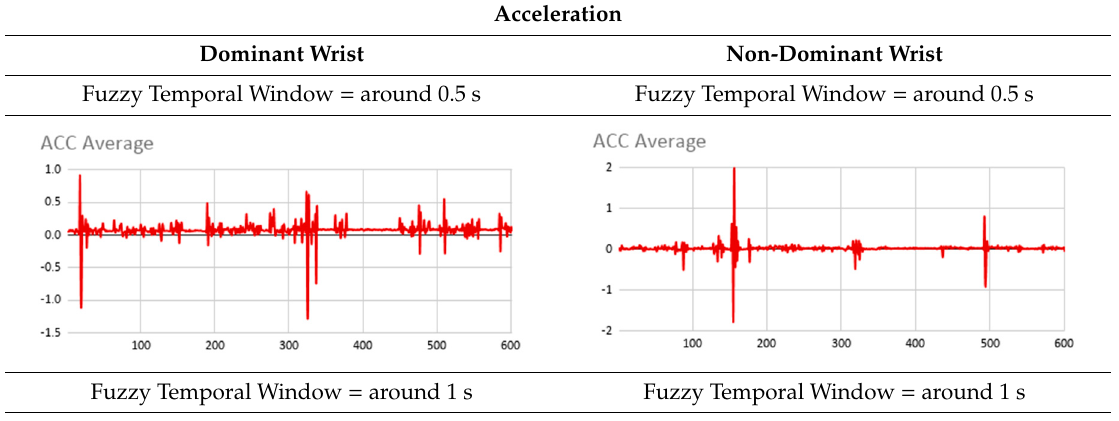
Table 4. Acceleration results with di ff erent fuzzy temporal windows from both wrists. Table 4. Acceleration results with different fuzzy temporal windows from both wrists. Table 4. Acceleration results with different fuzzy temporal windows from both wrists. Table 4. Acceleration results with different fuzzy temporal windows from both wrists. Table 4. Acceleration results with different fuzzy temporal windows from both wrists. Table 4. Acceleration results with different fuzzy temporal windows from both wrists. Table 4. Acceleration results with different fuzzy temporal windows from both wrists. Table 4. Acceleration results with different fuzzy temporal windows from both wrists. Table 4. Acceleration results with different fuzzy temporal windows from both wrists.